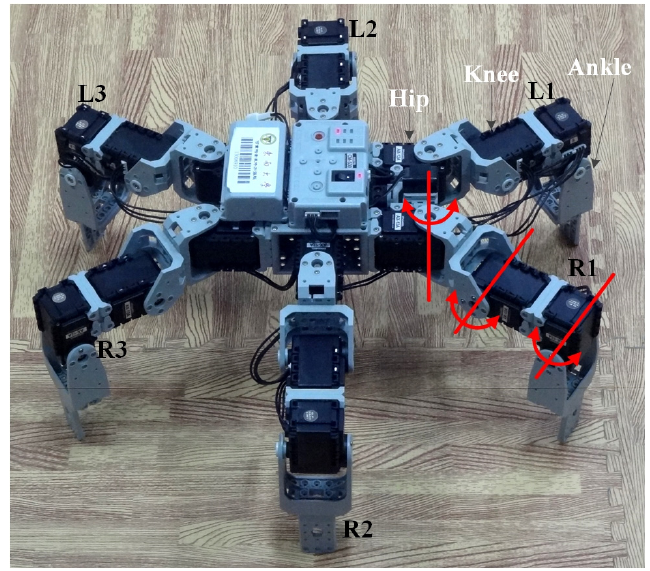
Figure 1. The hexapod robot platform.